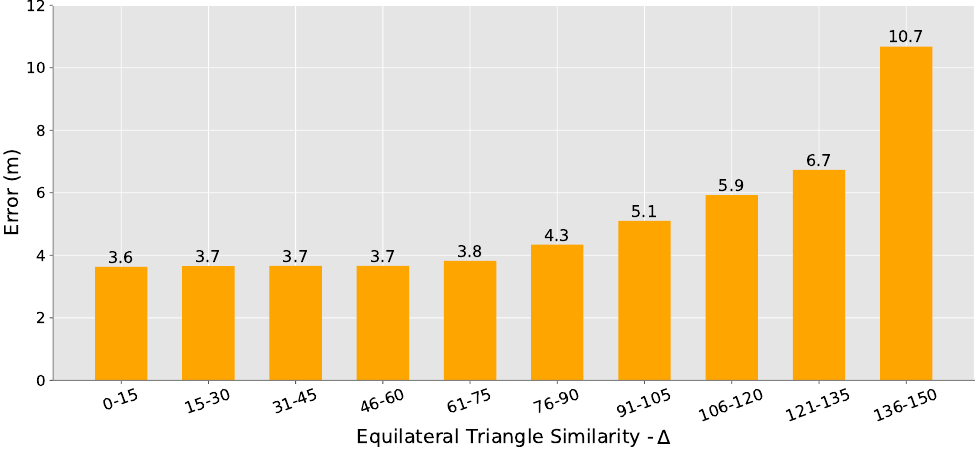
Figure 10. Positioning error by equilateral triangle similarity. The closer ∆ is from zero, the closer the anchor nodes are to form an equilateral triangle. For ∆ between 0 and 75, the error does not change